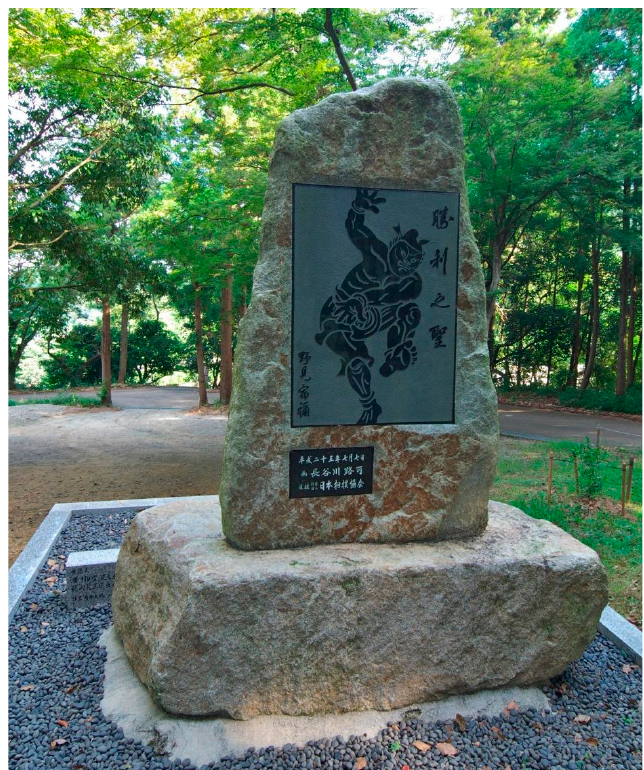
Figure 10. Stone stele “Holy Victory” featuring Hasegawa’s Nomi no Sukune at Sumo Shrine in Sakurai, Nara. Reproduced with permission from Seimenjo; published by photolibrary.jp (image no. 6130075) (accessed on 28 August 2021).